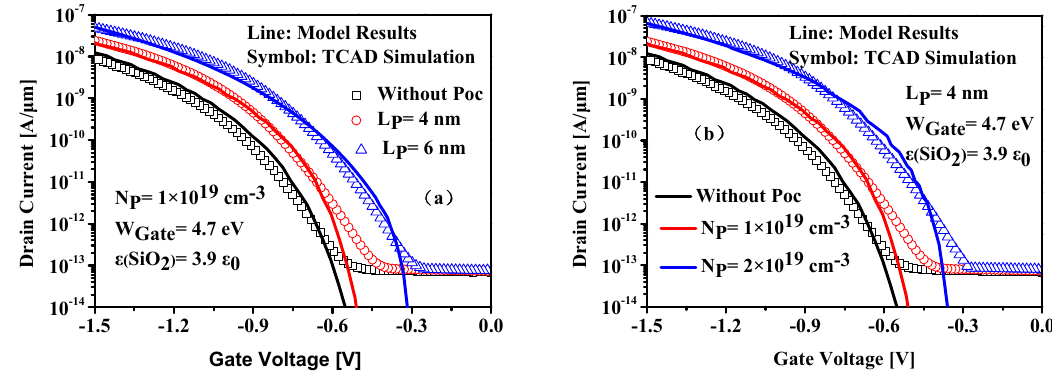
Figure 7. Transfer characteristics versus different ( a ) pocket doping concentrations and ( b ) pocket lengths.